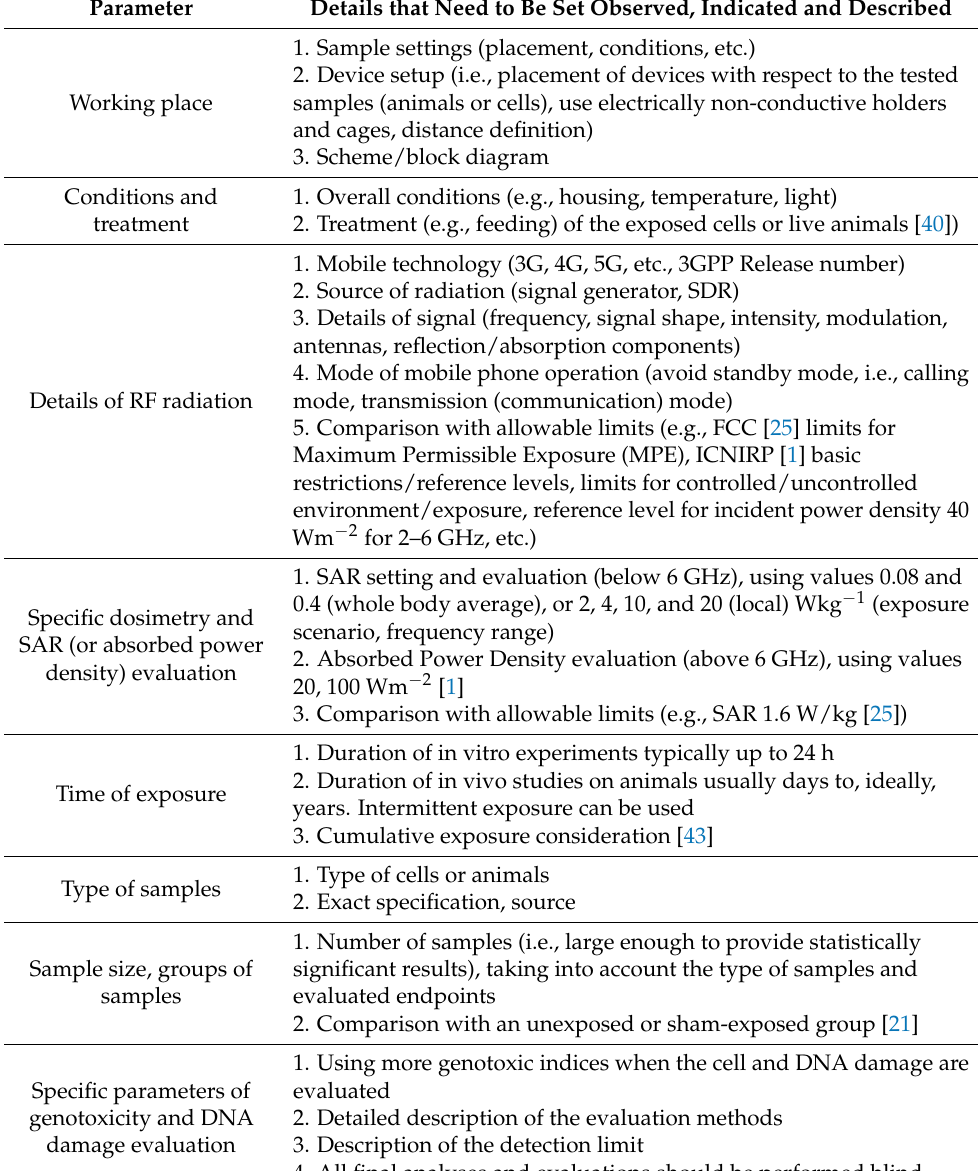
Table 1. Recommendation for conditions of the laboratory